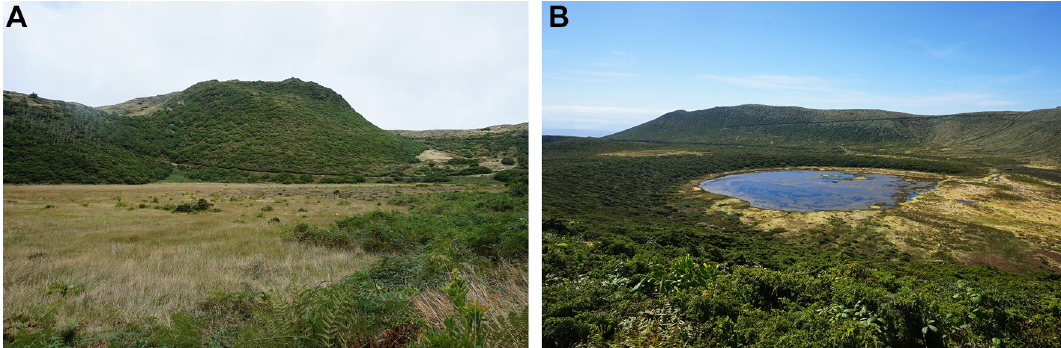
Fig. 2 Peatland landscape in the studied islands, Terceira (left) and Flores (right)